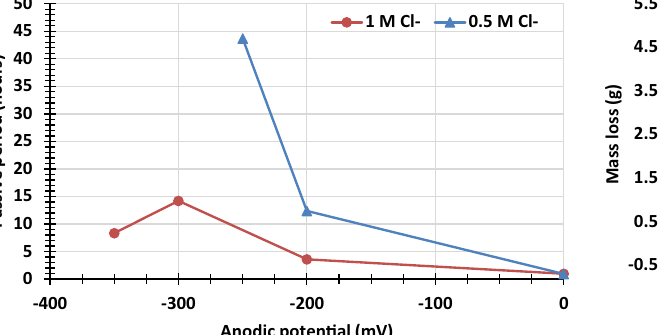
Figure 11: Gravimetrically - calculated ( solid line ) and theoretically - calculated ( dotted line ) mass loss of HSHCsw vs Cl − concentration at di ff erent APAs within passive zone that lasted for